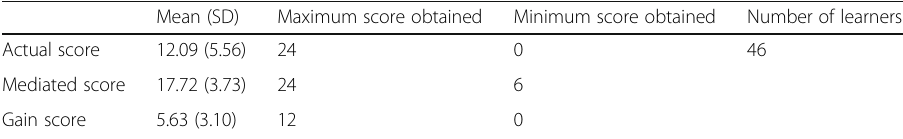
Table 1 A general description of actual, mediated, and gain